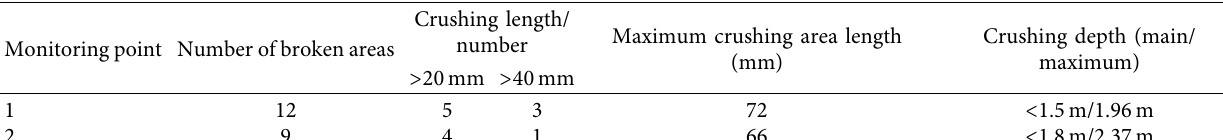
Figure 6: Characteristics of roof sag. (a) The final deformation of measuring points. (b) Roof displacement at measuring point 8. Table 1: Borehole imaging results.